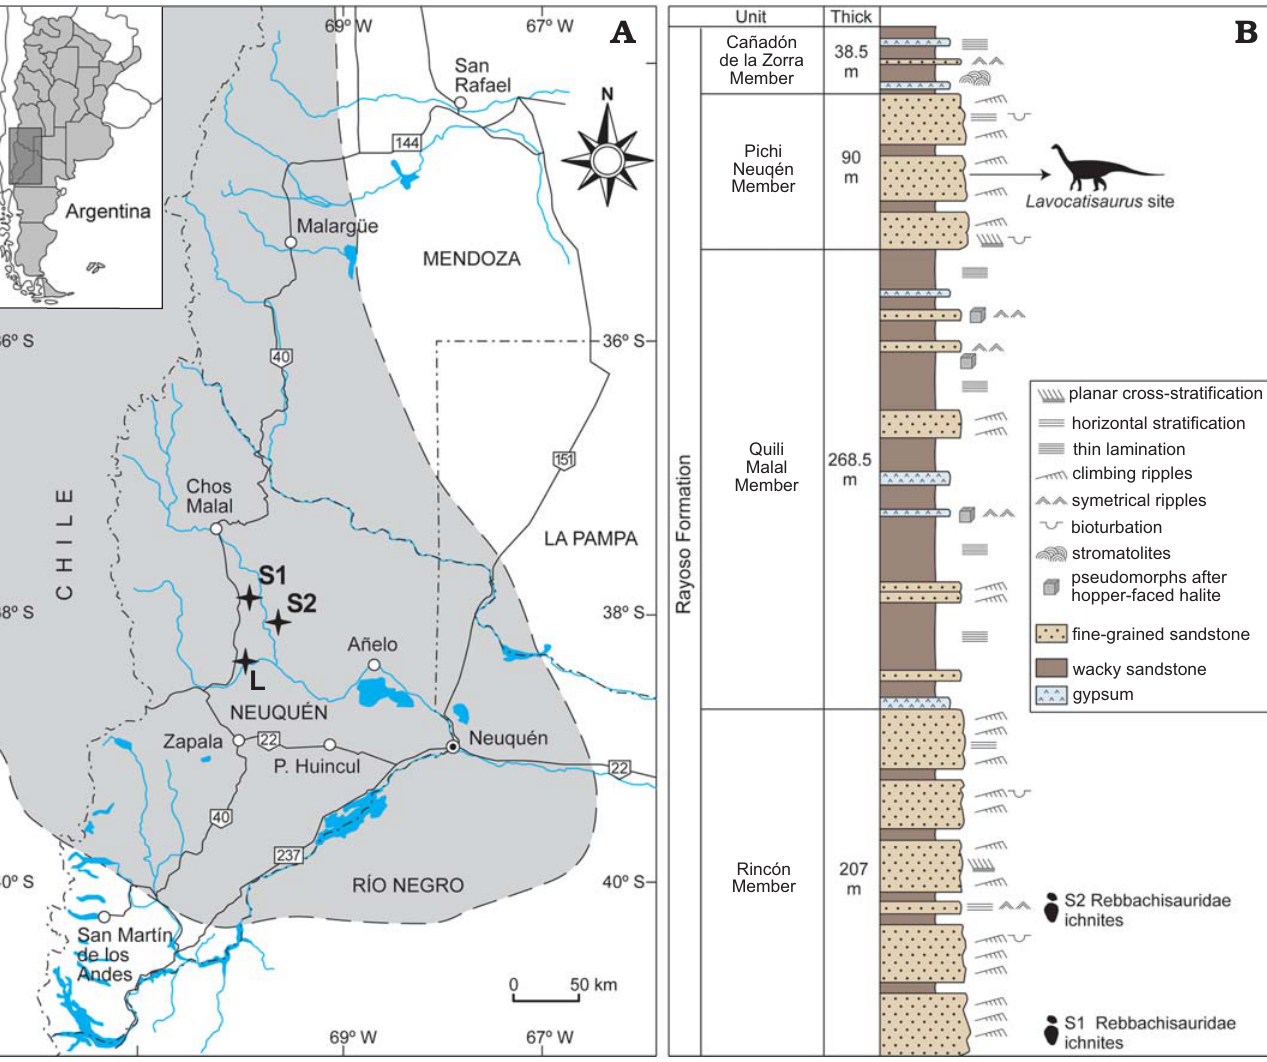
Fig. 1. A . Map of location and geological outcrops of the region of Agrio del Medio (Neuquén, Argentina), where the material was collected; gray area represents the Neuquén Basin. B . Litho stratigraphic column of the Rayoso Formation in the study area. L, Lavocatisaurus site; S1 and S2, sites of the Rebbachisauridae ichnites (Canudo et al.